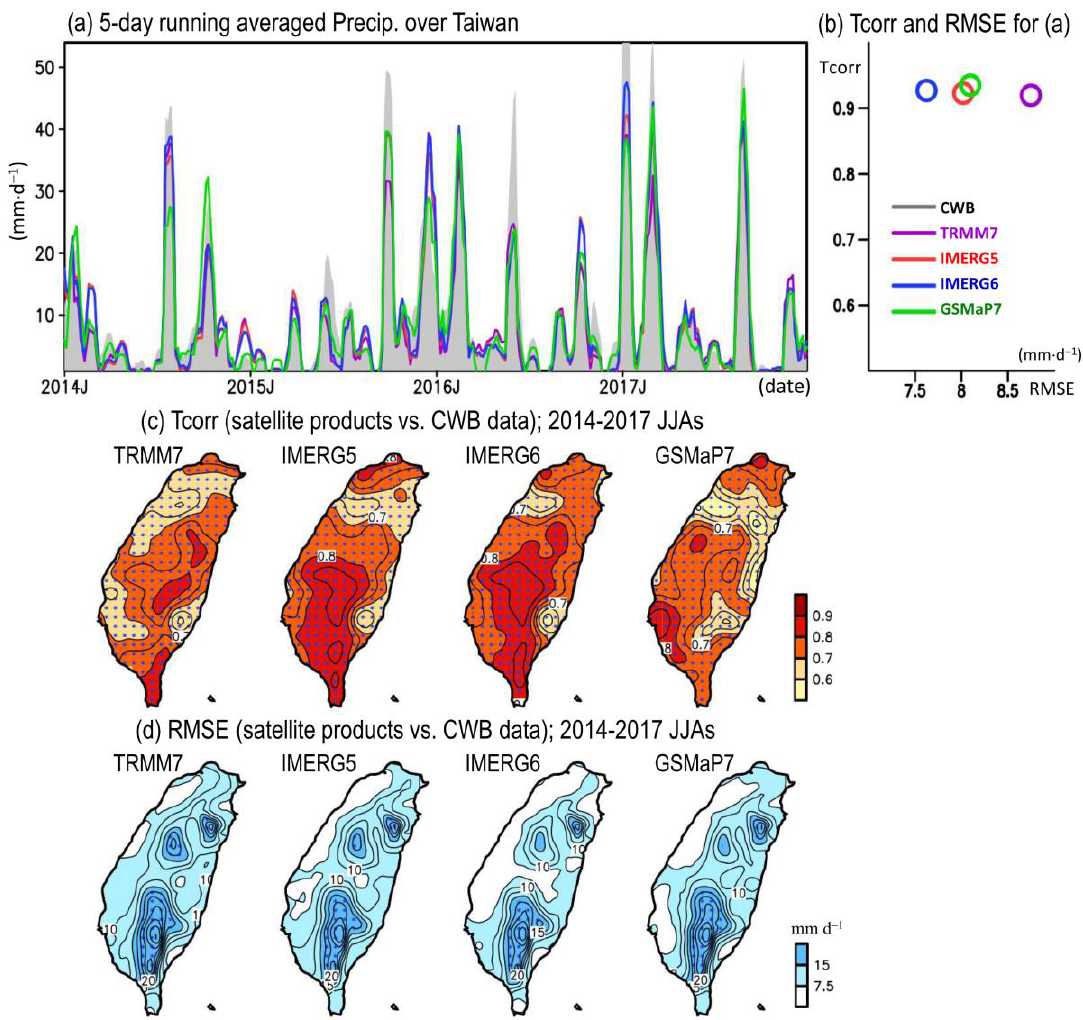
Figure 2. ( a ) Time series of 5-day running averaged precipitation over Taiwan, during the summers of 2014 – 2017, extracted from the CWB data and the four SPPs. The color symbols are described in ( b ). ( b ) Tcorr (i.e., temporal correlation) and RMSE between the time series of CWB data and SPPs in ( a ). ( c ) Grid-to-grid Tcorr between the time series of CWB data and SPPs. ( d ) Grid-to-grid RMSE between the time series of CWB data and SPPs. Here, the sample size for calculating Tcorr and RMSE is 368 days from summers of 2014 – 2017. In ( c , d ), the values pass the 99% significant test are marked by dots.